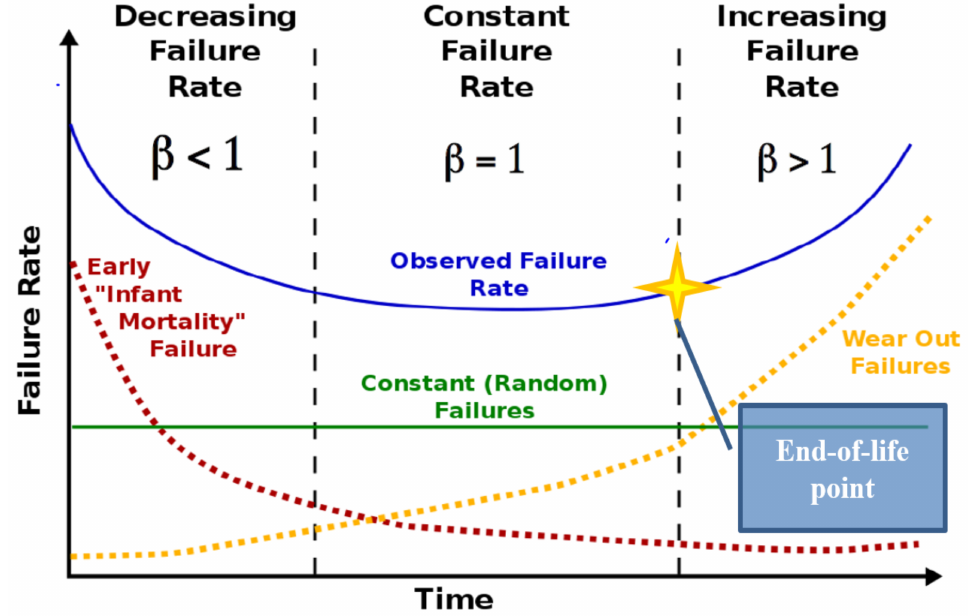
Figure 6. The Bathtub reliability curve is used to describe device failure-rate characteristics for nearly all devices. The relationship of Weibull plot slopes to the bathtub curve is set by the value of β .